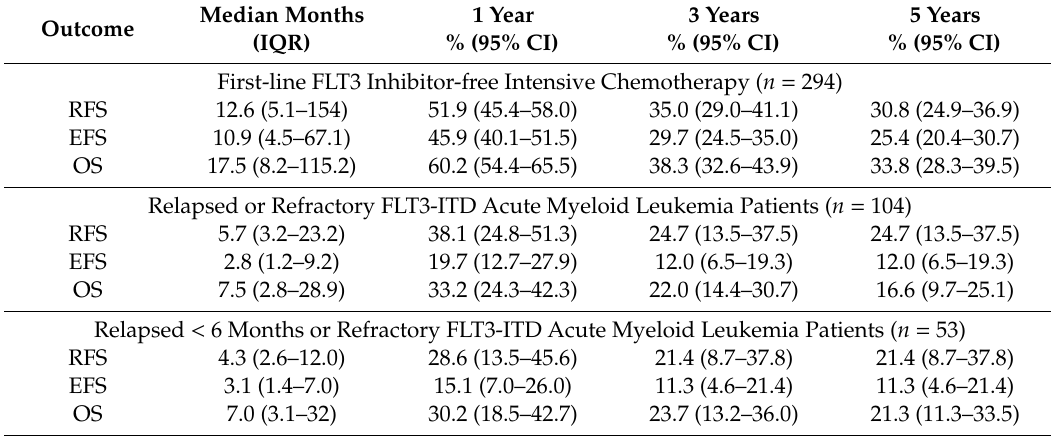
Table 2. Outcome of FLT3 -ITD AML patients in first line or R / R